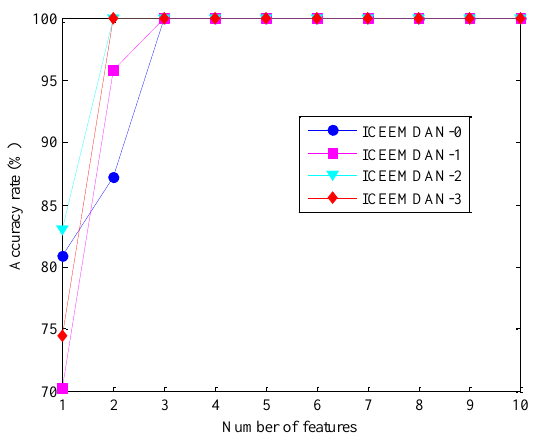
fault size of 0.021 inches) are depicted in Figure 6.